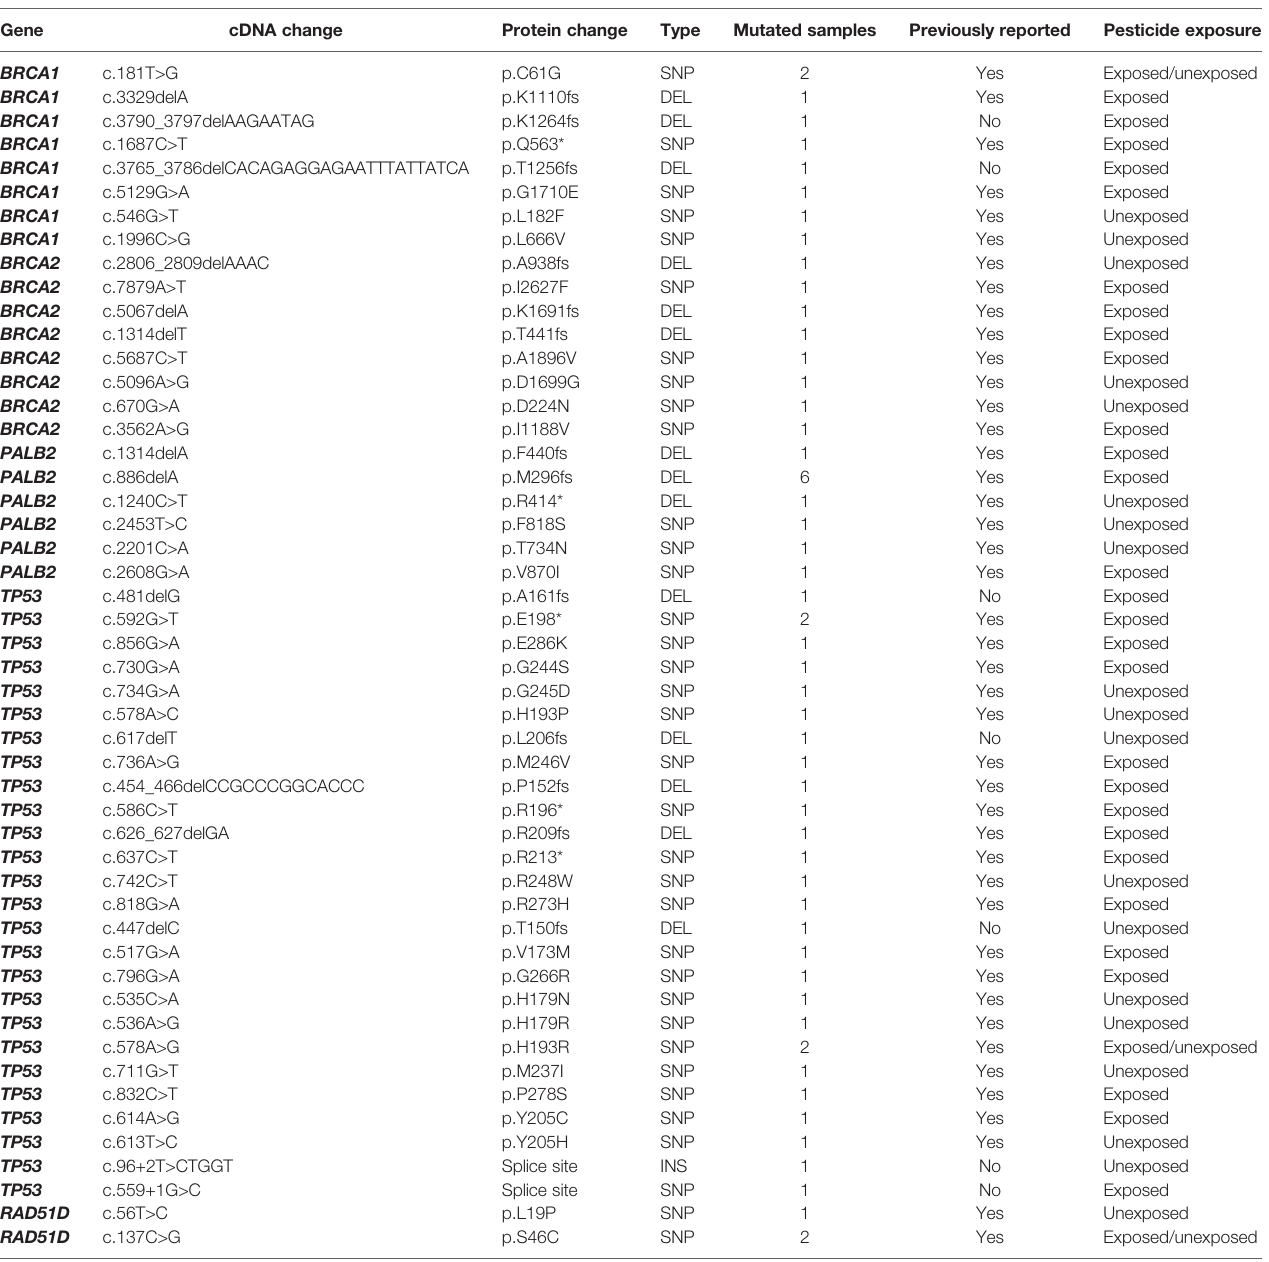
TABLE 2 | List of variants classi fi ed as pathogenic, likely pathogenic, and